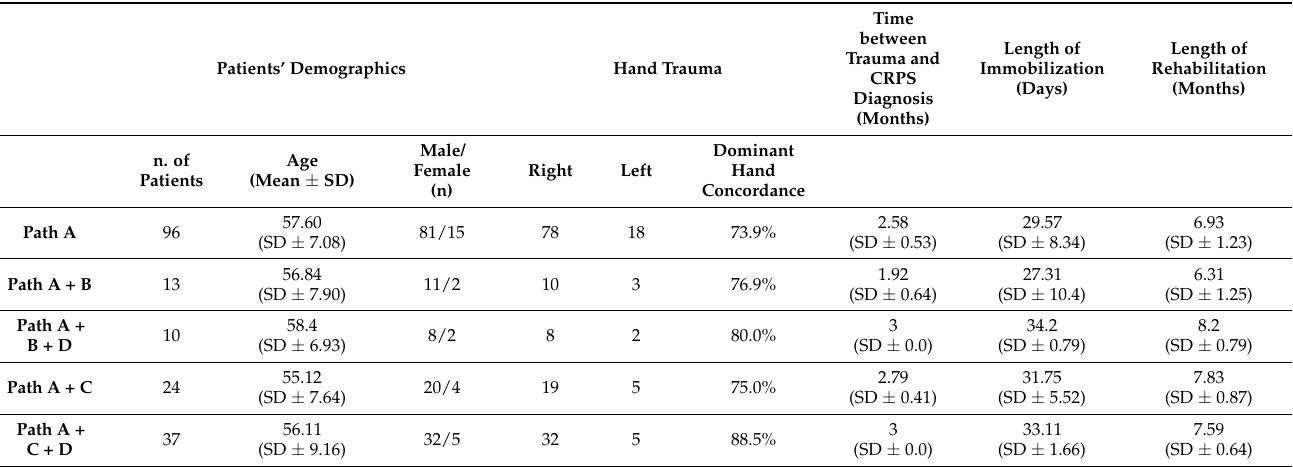
Table 1. Patients’ demographics and clinical